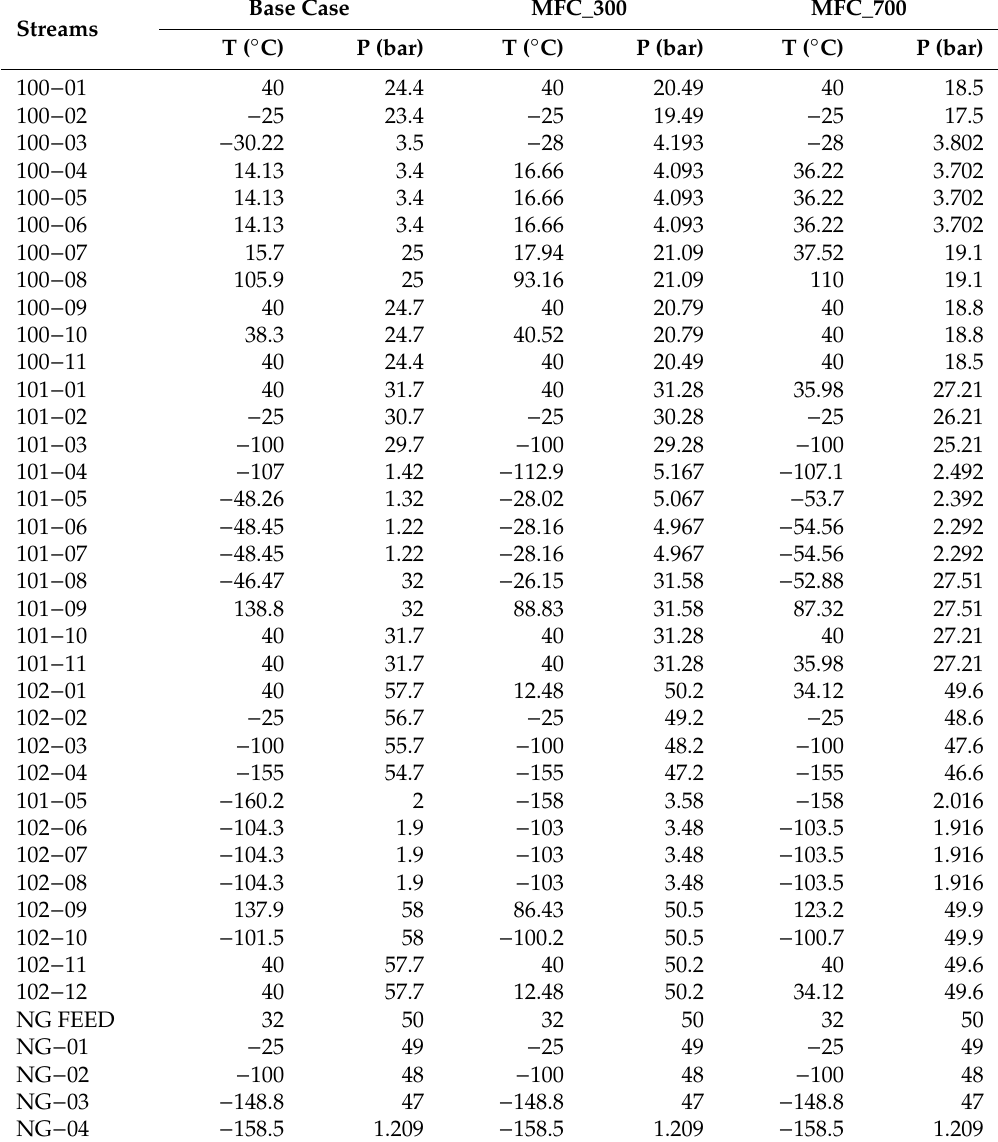
Table 4. Temperature and pressure for all streams of the studied MFC